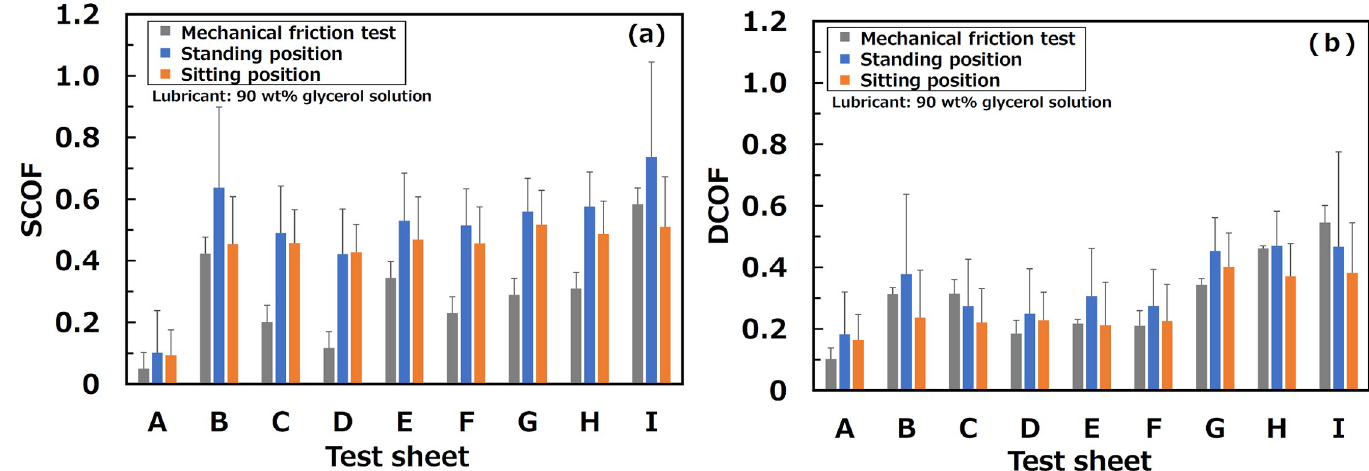
Fig 8. Comparison of COFs between mechanical friction test and foot rubbing test: (a) SCOFs and (b) DCOFs.